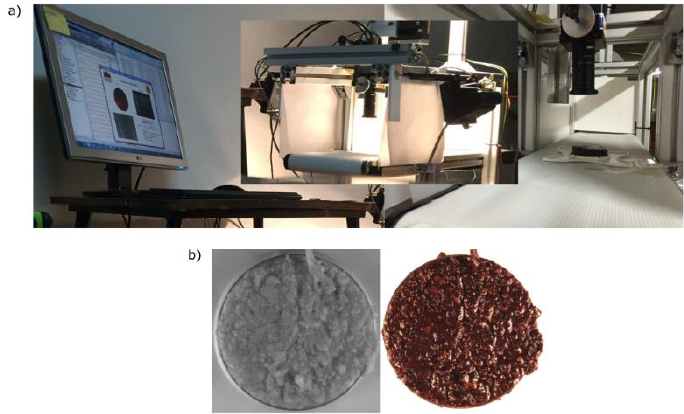
Figure 4. Image setup for at-line acquisitions. Subfigure ( a ) is composed by the vision camera, two halogen lamps and the conveyor belt. At the left of this subfigure appears the PC which handles the experimental setup. To the left of this subfigure is the Petri dish with a sample of paste below the vision device; Subfigure ( b ) displays the acquired images in the infrared ( left ) and color ( right ) channels.